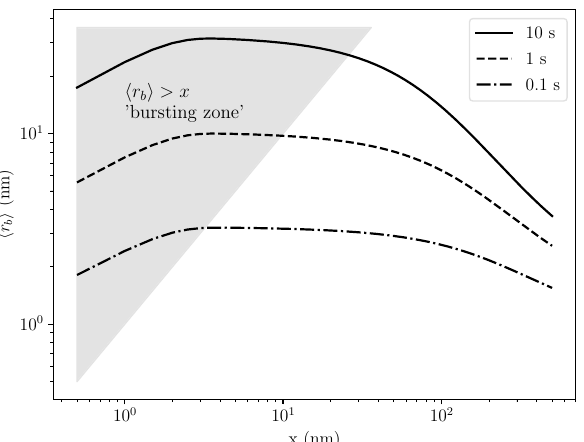
r b as a function of depth x in W exposed to 100 eV He at 10 22 m − 2 s − 1 (cid:31) (cid:30)